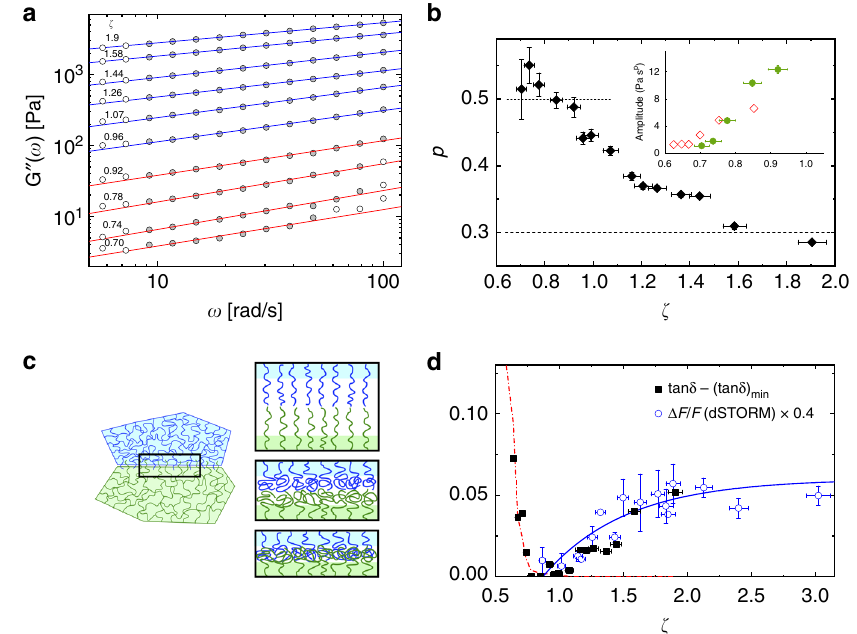
Fig. 4 Loss modulus, interfacial lubri fi action and friction in densely packed microgel suspensions. a Loss modulus G ″ ( ω ) for frequencies ω ≥ 4 rad/s for different packing fractions (symbols). Solid lines show the fi t to the data with G ″ ( ω ) = A ( ζ ) ω p . Data points included in the fi t range are fi lled dark gray. Lines with p ≃ 0.5 are red, p < 0.5 blue. b Values of p obtained by a best fi t to the data. Inset: concentration dependence of A ( ζ ), ζ ≤ 0.92. Full symbols show the data for microgels, corresponding to the red lines in a , open symbols for emulsions (from ref. 56 with p ≡ 0.5). c Illustration of corona – corona interactions at the interface between microgels, see also Fig. 2. Initially the dangling corona polymer chains are extended in a brush-like con fi guration. At higher densities ( ζ ~ ζ c ~ 1) the chains are compressed. For ζ > ζ c microgels interpenetrate. d Dissipative losses tan δ = G ″ / G ′ at ω = 1.2 rad/s. Solid